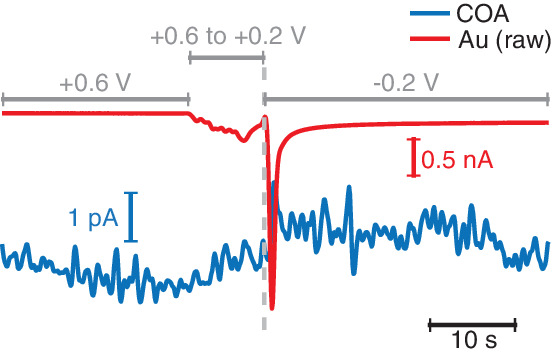
Oxygen measurement with the TACO sensor does not affect the simultaneously recorded COA signal.Example of a switch of the potential applied to the Au site in vivo from the normally used +0.6 V vs. Ag/AgCl in sentinel mode to −0.2 V vs. Ag/AgCl used for O2 measurement. No change was observed in the COA signal upon switching the polarity of the signal.